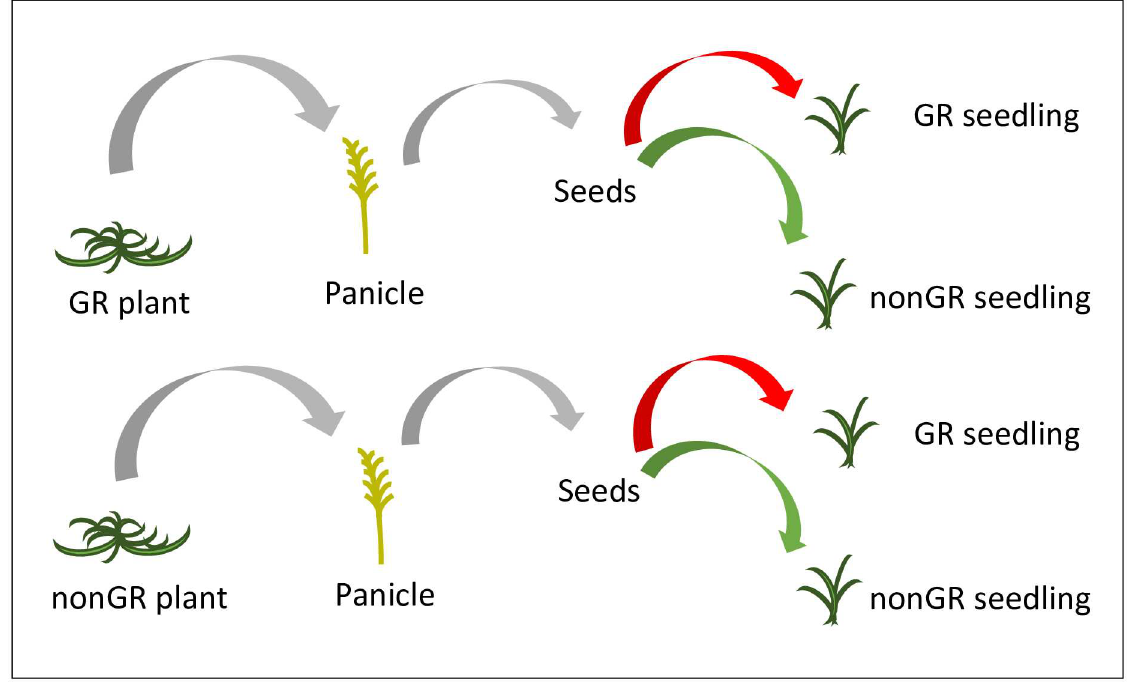
Fig 1. Schematics of seed collection and herbicide screening. Paniclescollected from transgenicglyphosate-resistant (GR) and glyphosate-susceptible (non GR) plants established in situ were threshed and the seeds were screenedfor the presenceof the